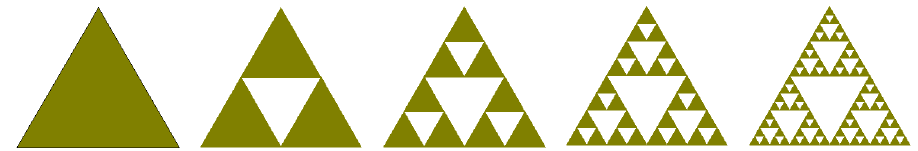
Figure 14. Sierpinski gasket antenna through five stages of growth.